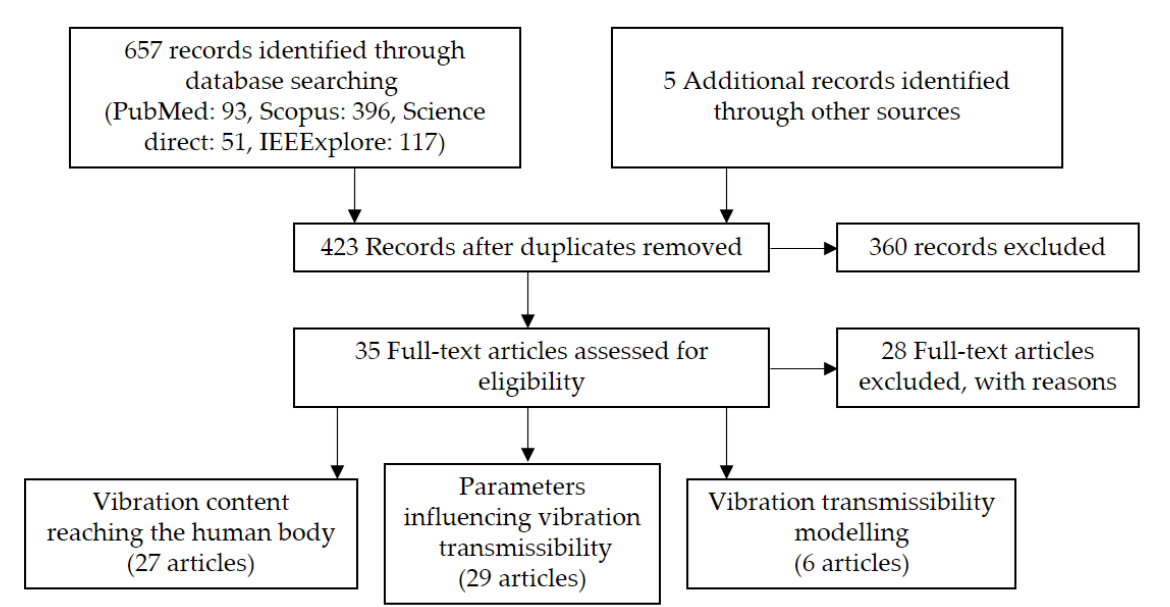
Figure 1. PRISMA flow diagram presented article selection Figure A1. PRISMA flow diagram presented article selection [34].